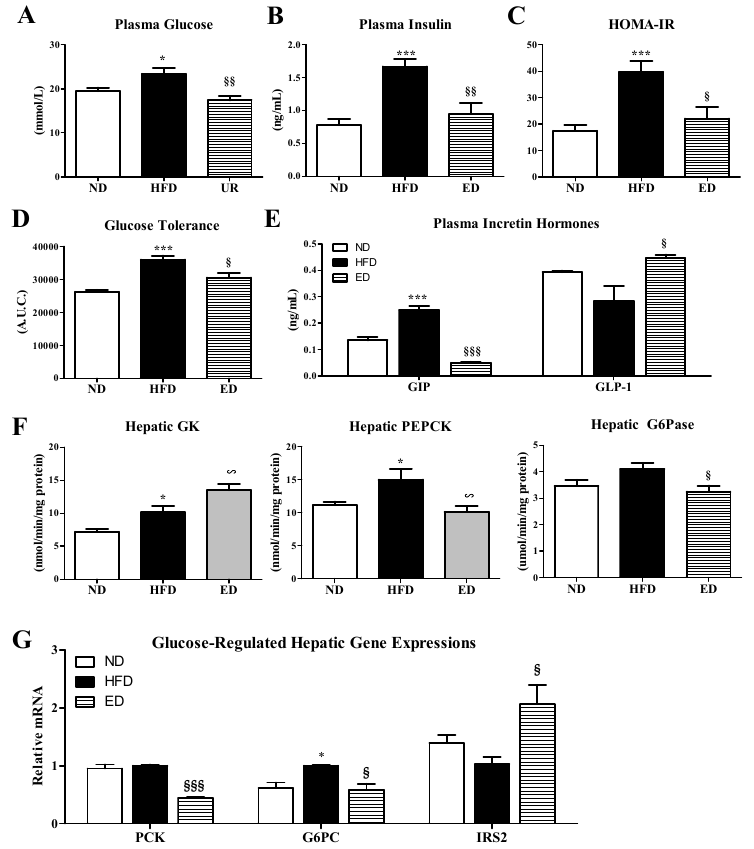
Figure 4. Effect of eriodictyol treatment on the plasma glucose ( A ) and insulin ( B ) levels, HOMA-IR ( C ), glucose tolerance ( D ), plasma incretin hormones ( E ), activities of hepatic glucose-regulating enzyme ( F ), and expression levels of hepatic glucose-regulating genes in C57BL/6N mice fed with the high-fat diet (HFD). Data are presented as means ± SEM. Normal diet (ND; AIN-76) vs. HFD; * p < 0.05, *** p < 0.001. HFD vs. ED (HFD + 0.005% ED); § p < 0.05, §§ p < 0.01, §§§ p < 0.001. HOMA-IR, homeostasis model assessment of insulin resistance; GIP, gastric inhibitory polypeptide; GLP-1, glucagon-like peptide-1; GK, glucokinase; PEPCK, phosphoenolpyruvate carboxykinase; G6Pase, glucose-6-phosphatase; PCK, PEPCK; G6PC, G6Pase; IRS2, insulin receptor substrate